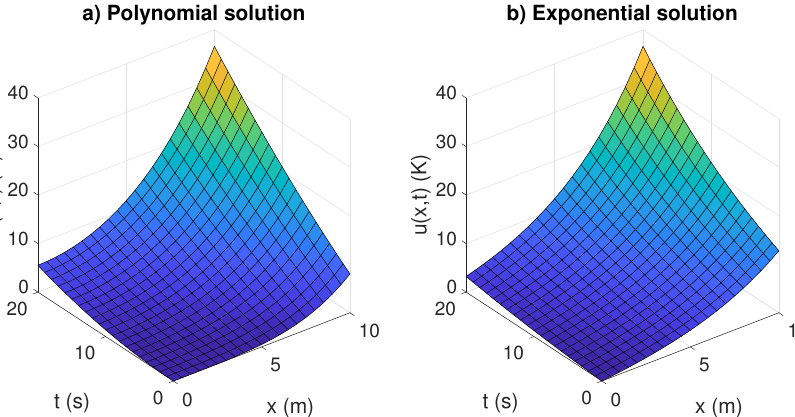
Figure 4. ( a ) Scalar field resulting from Equation (11) with β 1 = 0.8 × 10 − 3 , β 2 = 0, β 3 = 0, and α = 1.2. ( b ) Scalar field resulting from Equation (17) with β 1 = − 0.2, β 2 = 0, β 3 = 0, β 4 = 2, β 5 = − 2, and α =